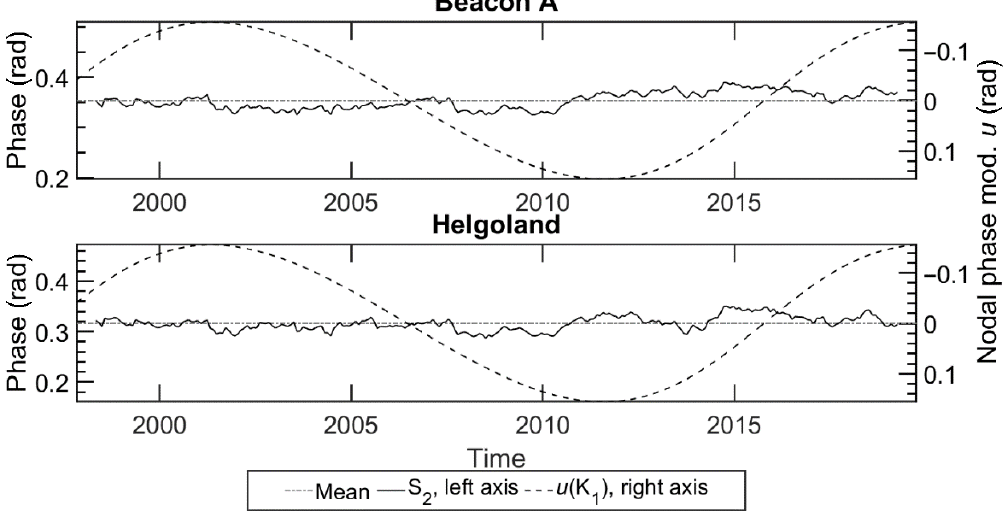
Figure 5. Phase on the S 2 frequency, determined for 365.25 d intervals, shifted by 29.5 d shown together with the nodal phase correction u of the K 1 ( u (K 1 ) = u (KP 2 )).